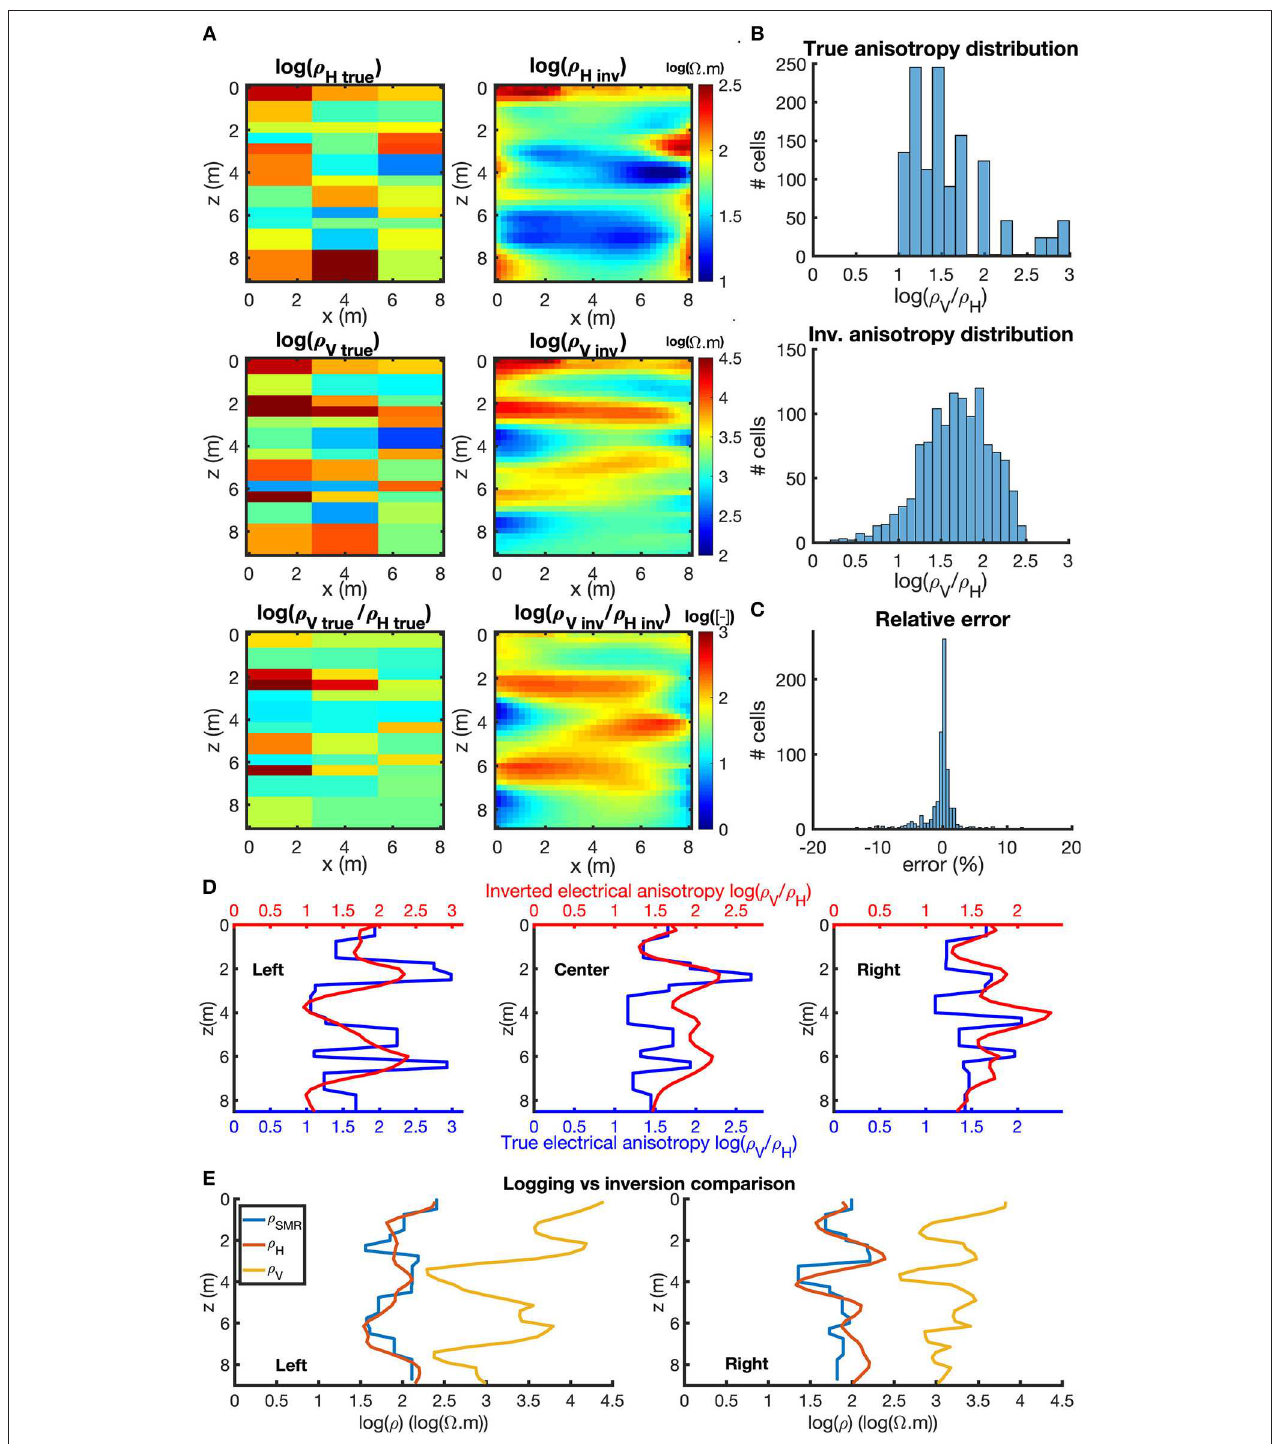
FIGURE 6 | Synthetic study anisotropic inversion results displaying logarithmic inverted resistivities. Unless otherwise stated, ρ H and ρ V represent the components of the inverted resistivity ρ Hinv and ρ Vinv . (A) True and inverted resistivity models (wells at x 0 m and x 8 m). (B) Histograms of the true and inverted anisotropy = = distributions. (C) Histogram of the relative error between measured and inverted ρ app . (D) Comparison between true (blue curves) and inverted (red curves) anisotropies. To compensate the resolution difference, the inverted anisotropy is averaged on the 2.5 m around the wells and in the center of the modeled section. (E) Comparison between the logged ( ρ SMR , blue curves), and the inverted horizontal ( ρ H , red curves) and vertical ( ρ V , yellow curves) resistivities (corresponding to the left and right resistivities section). Notice the similarities between ρ SMR and ρ H